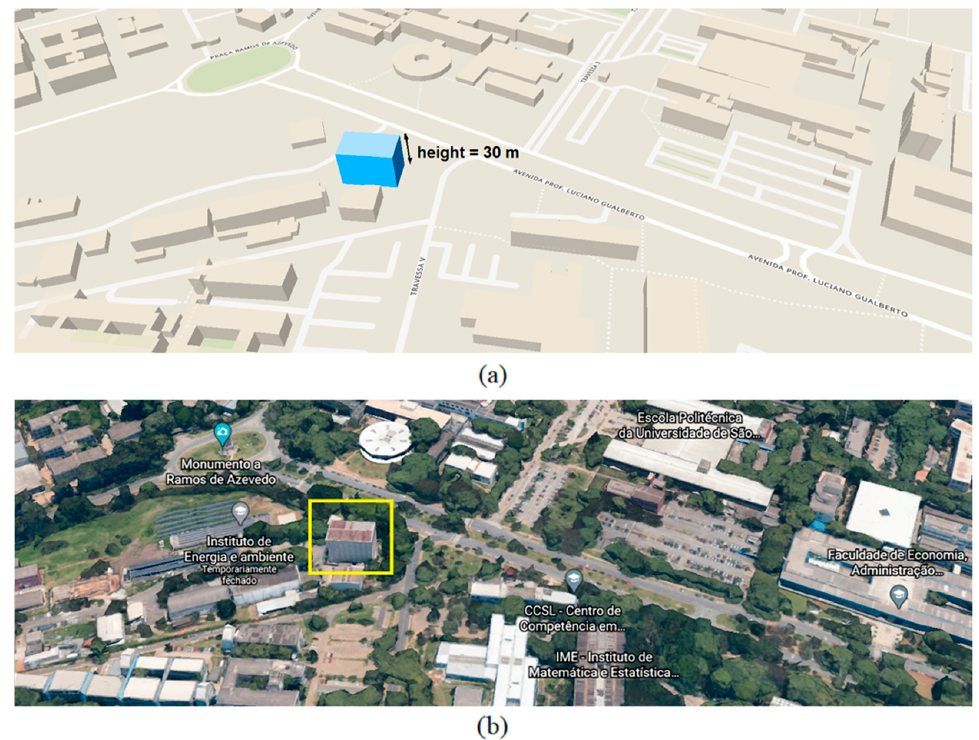
Figure 6. 3D aerial views of the area. ( a ) Highlighted building (adapted from [24]) ( b ) Satellite view of the area showing the vegetation (adapted from [25]).